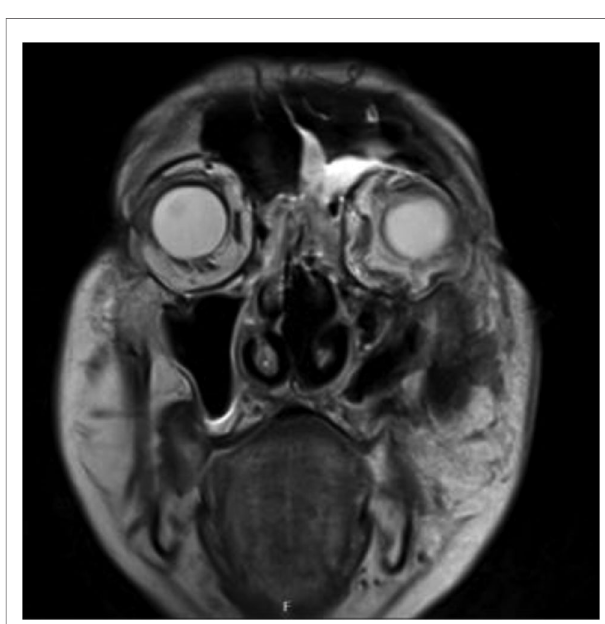
FIGURE 3 | Coronal MRI of the orbits and sinuses taken on the fourth day after hospital admittance: cellulitis of the left orbit with hyperintense signal in preseptal and postseptal areas. In fl ammatory thickening of the mucosal lining of the left frontal sinus, ethmoid cells, and maxillary